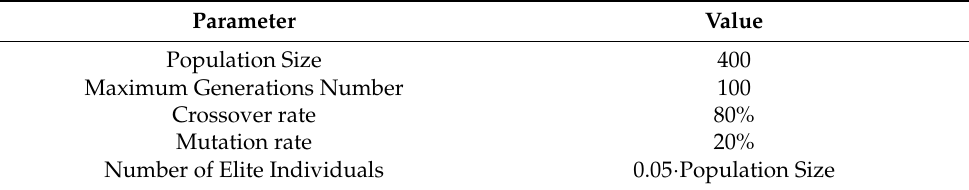
Table 2. GA parameters and